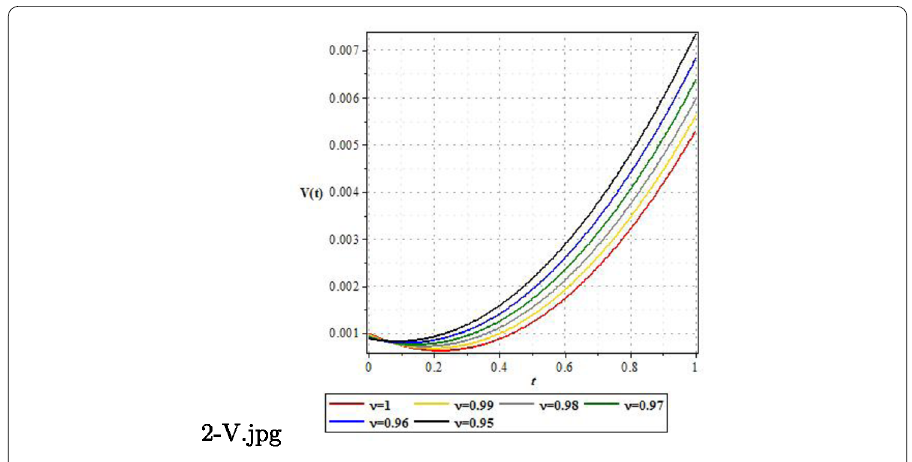
Figure 2 Dynamics of free HIV virus particles in the blood for various values of ν